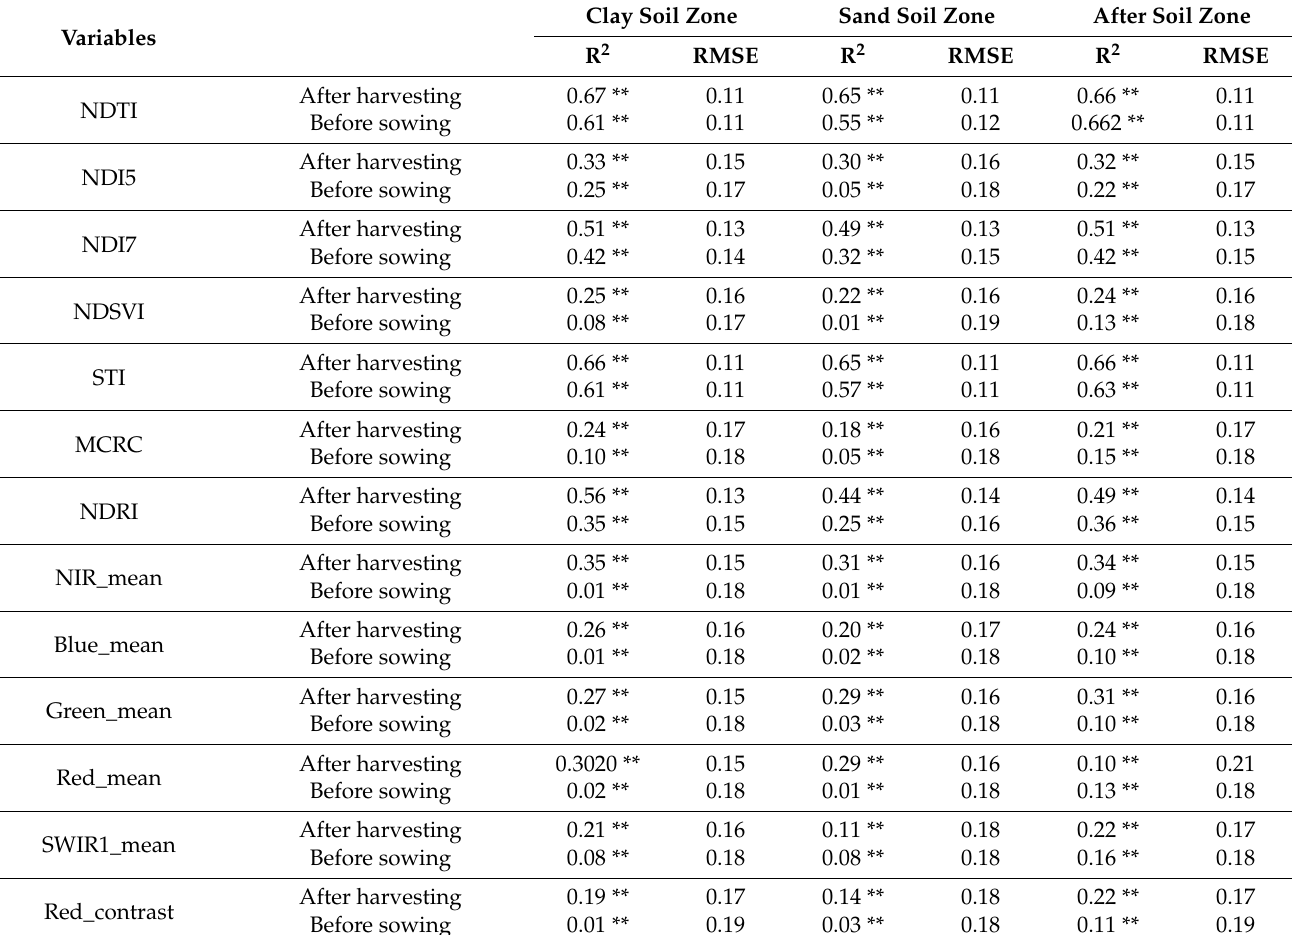
Table 6. Determination coefficient between spectral index, texture feature, and CRC of surface soil after texture